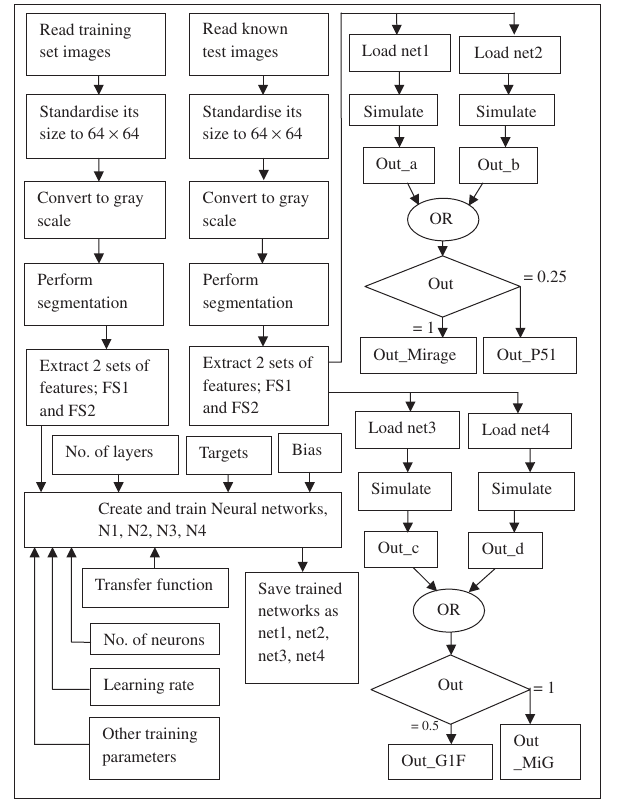
Figure 4: Flowchart for the